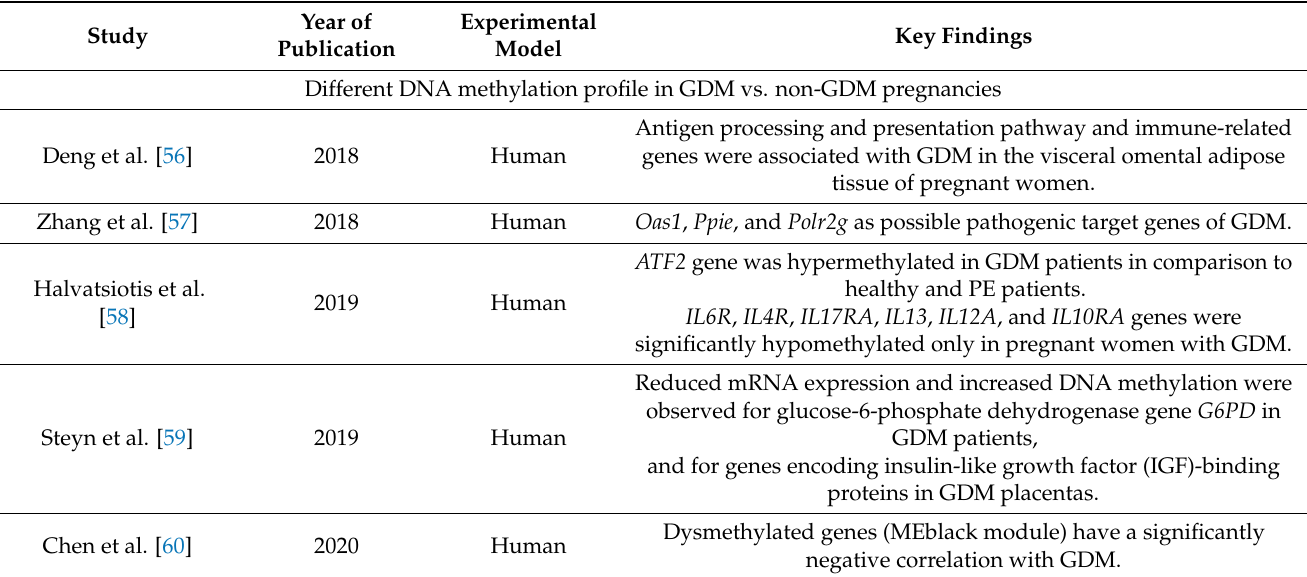
Dysmethylated genes (MEblack module) have a significantly Human negative correlation with